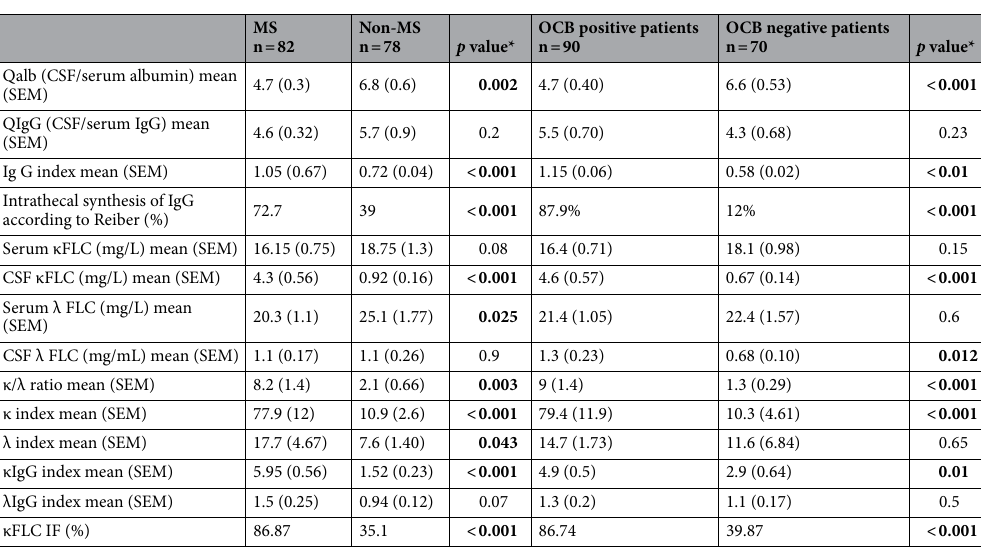
Table 2. Quantitative results of the different B cell-related parameters in CSF in the study population. FLC free light chain, MS multiple sclerosis, OCB oligoclonal bands, CSF cerebrospinal fluid, FLC IF free light chain intrathecal fraction, SEM standard error of the mean. *Student-t test. Significant p values are in